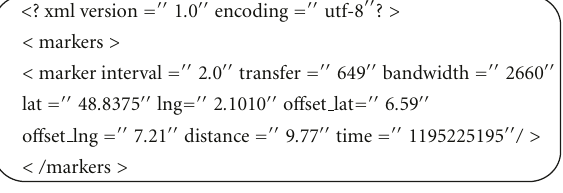
Figure 9: XML data file generated based on IPerf measurements.